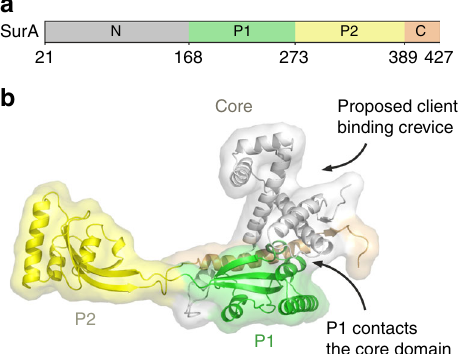
Fig. 1 SurA structure and domain architecture. a Domain architecture of E. coli SurA. Regions are coloured grey (N-terminal region of the core domain), green (P1), yellow (P2) and orange (C-terminal region of the core domain). The signal sequence is not shown, and was not present in any of re fl ects the gene numbering (including the signal peptide). b Crystal structure of E. coli SurA WT (PDB 1M5Y 27 ), with missing residues